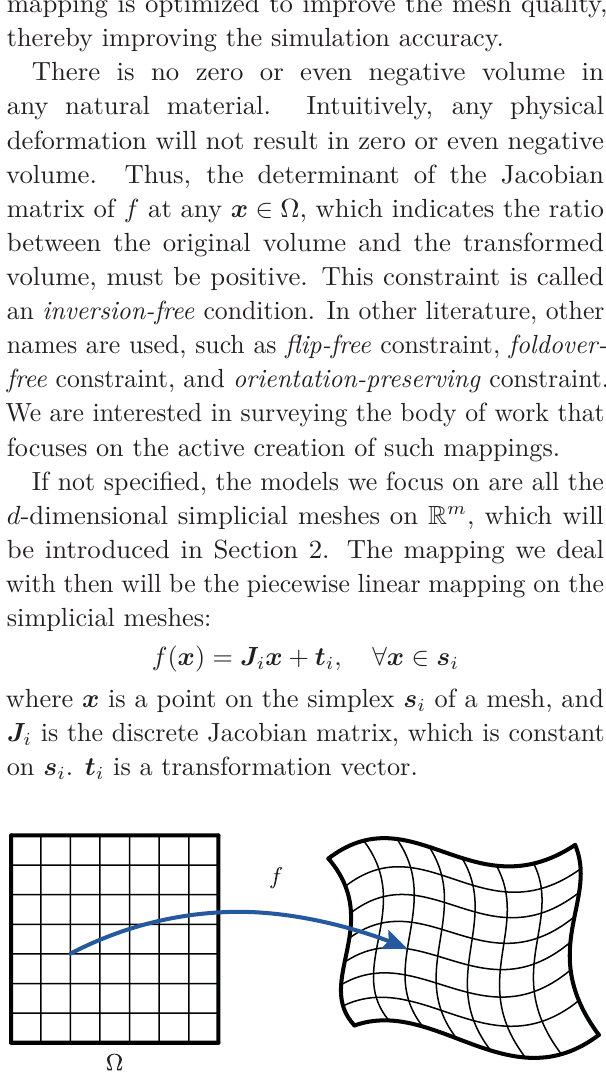
Fig. 1 Illustration for the geometric mapping f